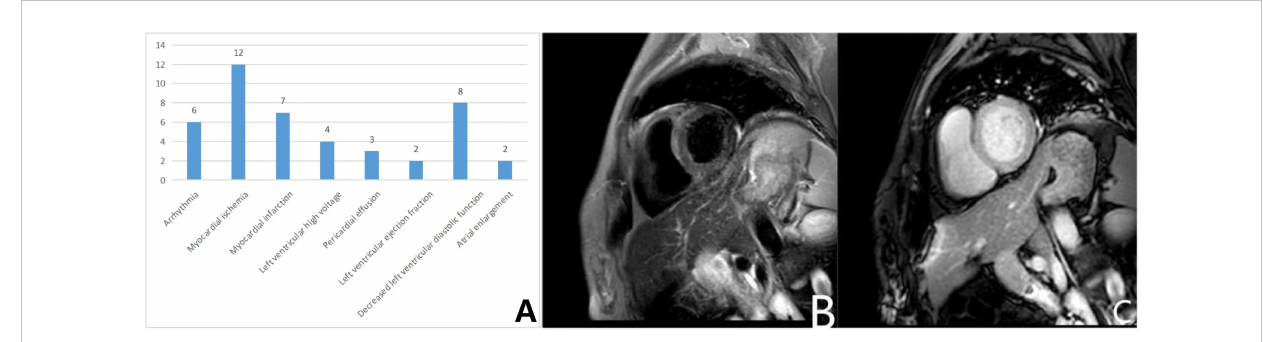
FIGURE 2 Cardiac involvements in IMNM patients. (A) Numbers and types of patients with cardiac symptoms in the IMNM; (B, C) Plain and enhanced myocardial MR scan. (B) The T2 STIR sequence showed diffused long T2 signal in the left ventricular myocardium; (C) No signi fi cant myocardial enhancement was seen in the T1 enhancement